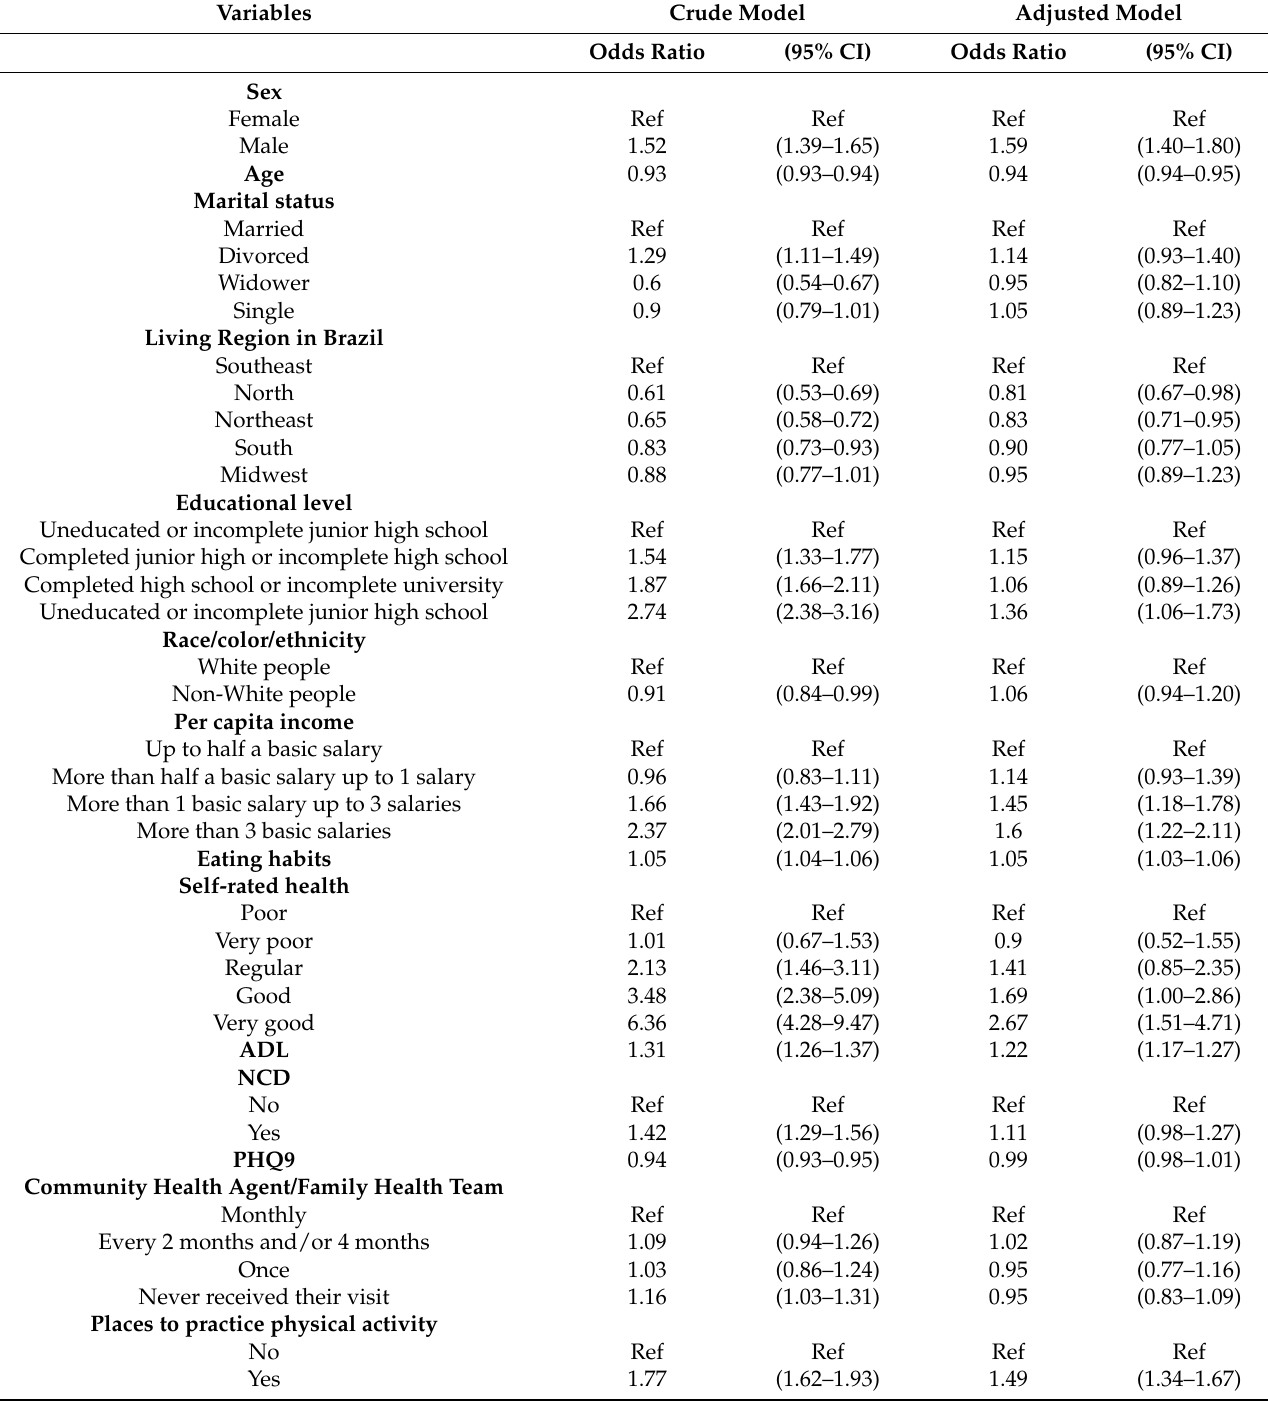
Table 3. Associated factors with total physical activity on Brazilian older